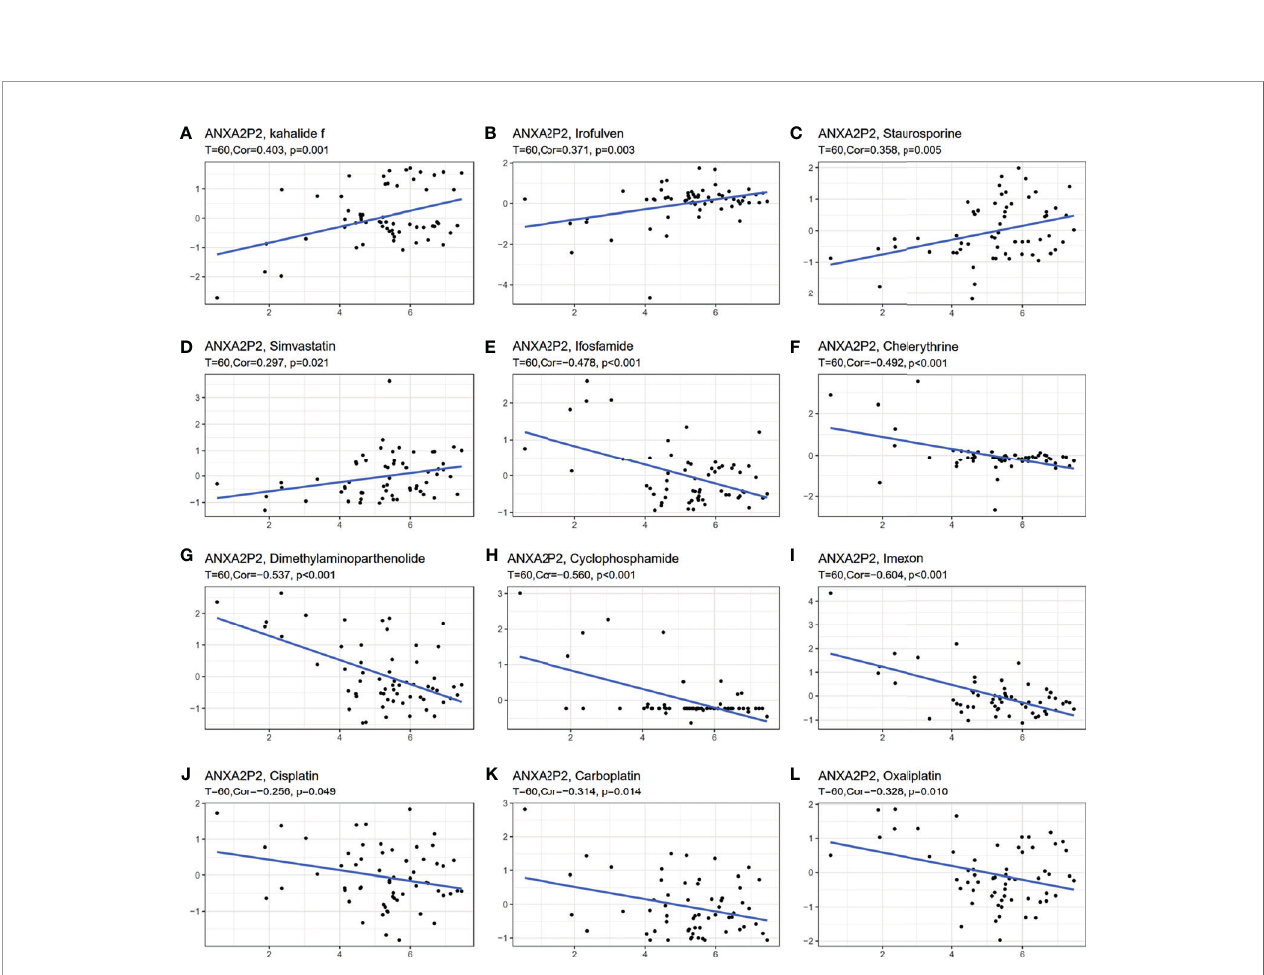
FIGURE 7 | Correlation between ANXA2P2 and IC50 of drugs. (A) Kahalide f; (B) irofulven; (C) staurosporine; (D) simvastatin; (E) ifosfamide; (F) chelerythrine; (G) dimethylaminoparthenolide; (H) cyclophosphamide; (I) imexon; (J) cisplatin; (K) carboplatin; and (L)